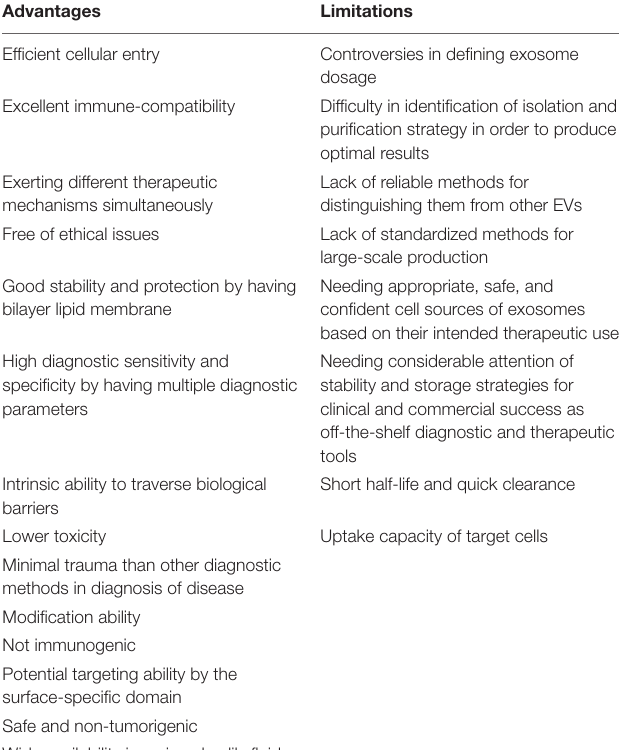
TABLE 5 | Advantages and limitations of exosomes therapy in clinical applications (Tian et al., 2010; Takahashi et al., 2013; Lötvall et al., 2014; Yu et al., 2014; Théry et al., 2018; Xing et al., 2020; Babaei and Rezaie,